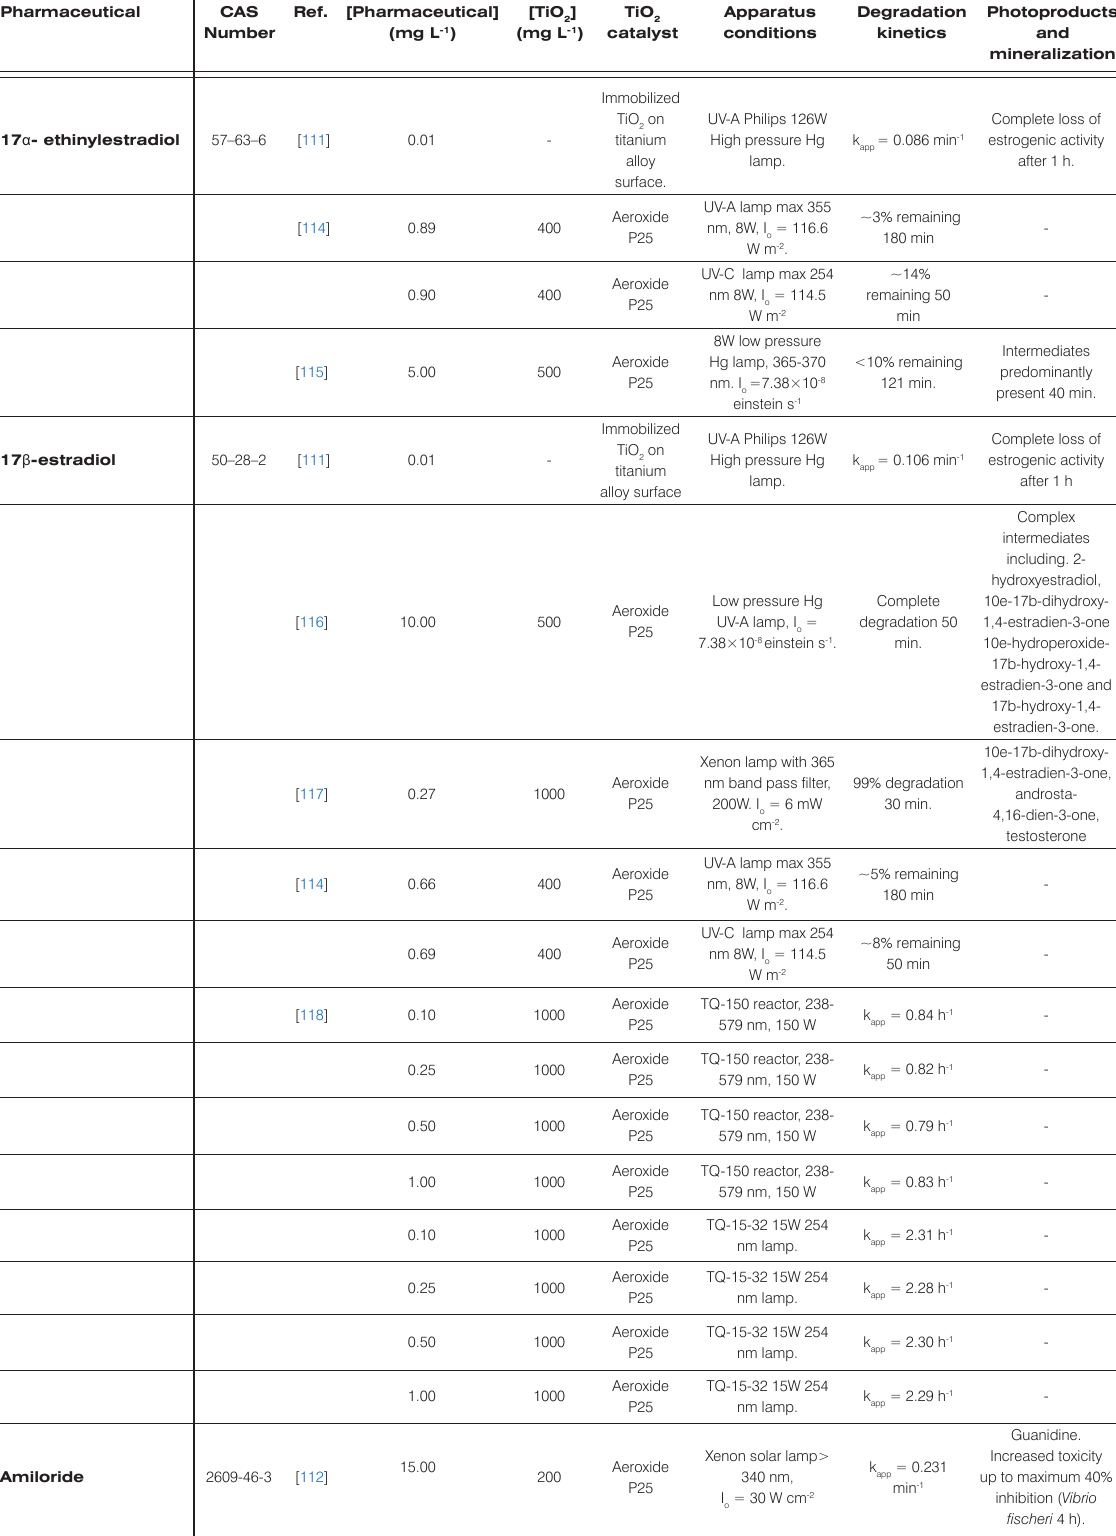
Table 1. Pharmaceuticals reported to degrade via TiO